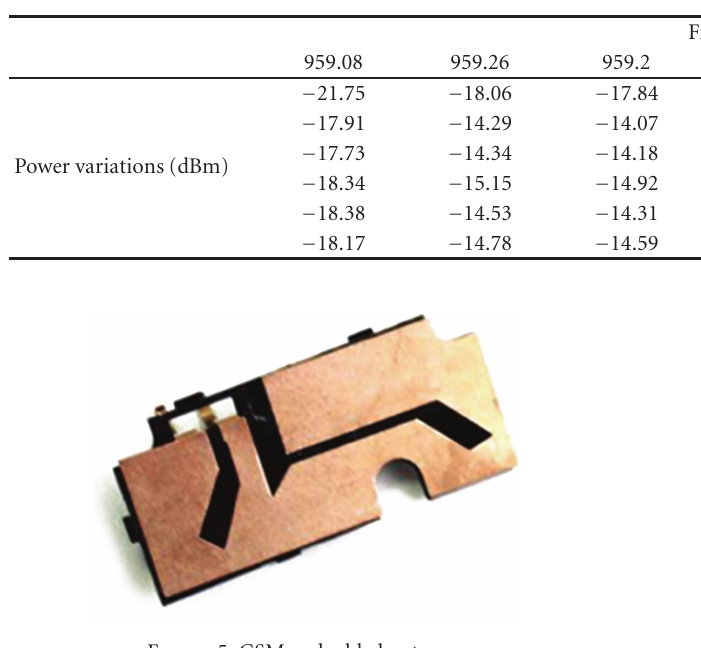
Table 2: Frequency variations at di ff erent time instances.